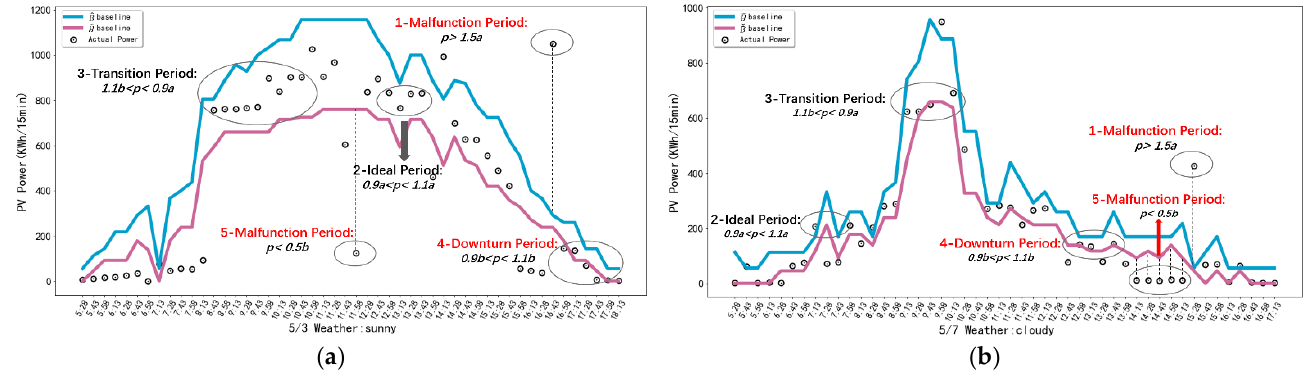
Figure 6. Five kinds of distribution on ( a ) a sunny day and ( b ) a cloudy day. In order to explicitly present the performance evaluation, we plot the warning boundary lines in Figure 7a,b. In the monitoring system, the engineers are capable of directly distinguishing the PV panel statuses and getting suggestions about how to carry out proper O&M plans. As in Figure 7a, the PV power generation experiences an abrupt decline and drops greatly at 14:28 in 2018/5/11, which indicates that the PV station is in a malfunction period and maintenance is required. According to the abrupt decline and long-lasting Stage 5, we consider that there is direct fault in the PV plant, e.g., nonconnected modules and short/open circuits. Such direct faults are relatively easy to notice in a monitoring system. They usually happen in Stage 5, accompanied by an obvious and long-term decline of PV generation. In this case, further O&M plans lie in checking detailed PV records about each panel and then locating the faulty one(s). As in Figure 7b, a cloudy day in summer, the solar irradiance is strong, so the curves of p , a , and b are nearly sinusoids shape. At 10:37, both A and B baselines fall greatly, whereas the actual p stays in the original trend. There is a high chance that meteorological sensor errors or transmission mistakes appear. The wrong data are input to our prediction models, so we get wrong results. We suggest that further O&M plans attach importance to check the original database and repair or replace faulty sensors.